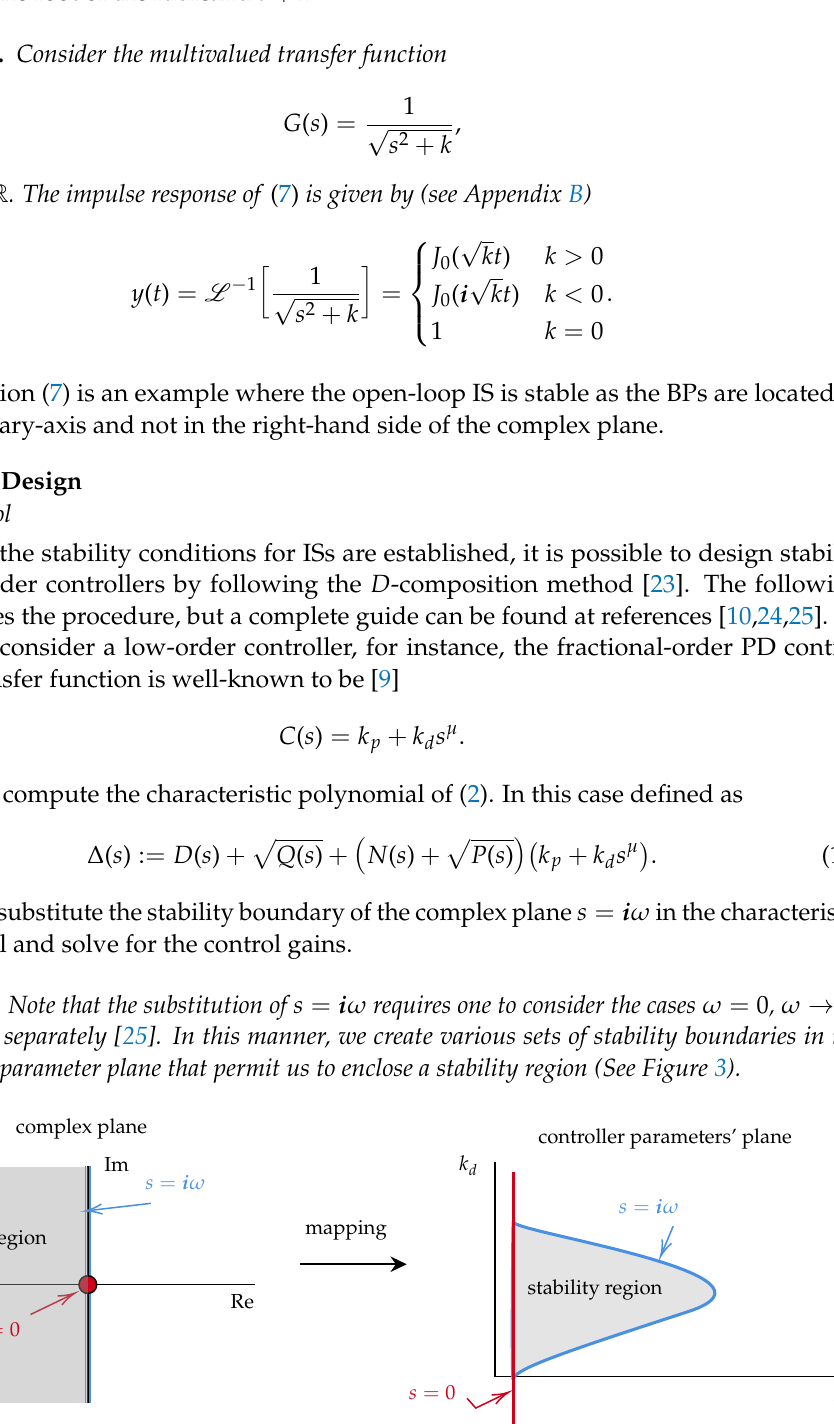
Figure 3. Example of the D-composition method. The method maps the complex plane stability region to the controller parameters’ plane. In this case, the plane has not stability boundary at s → ∞